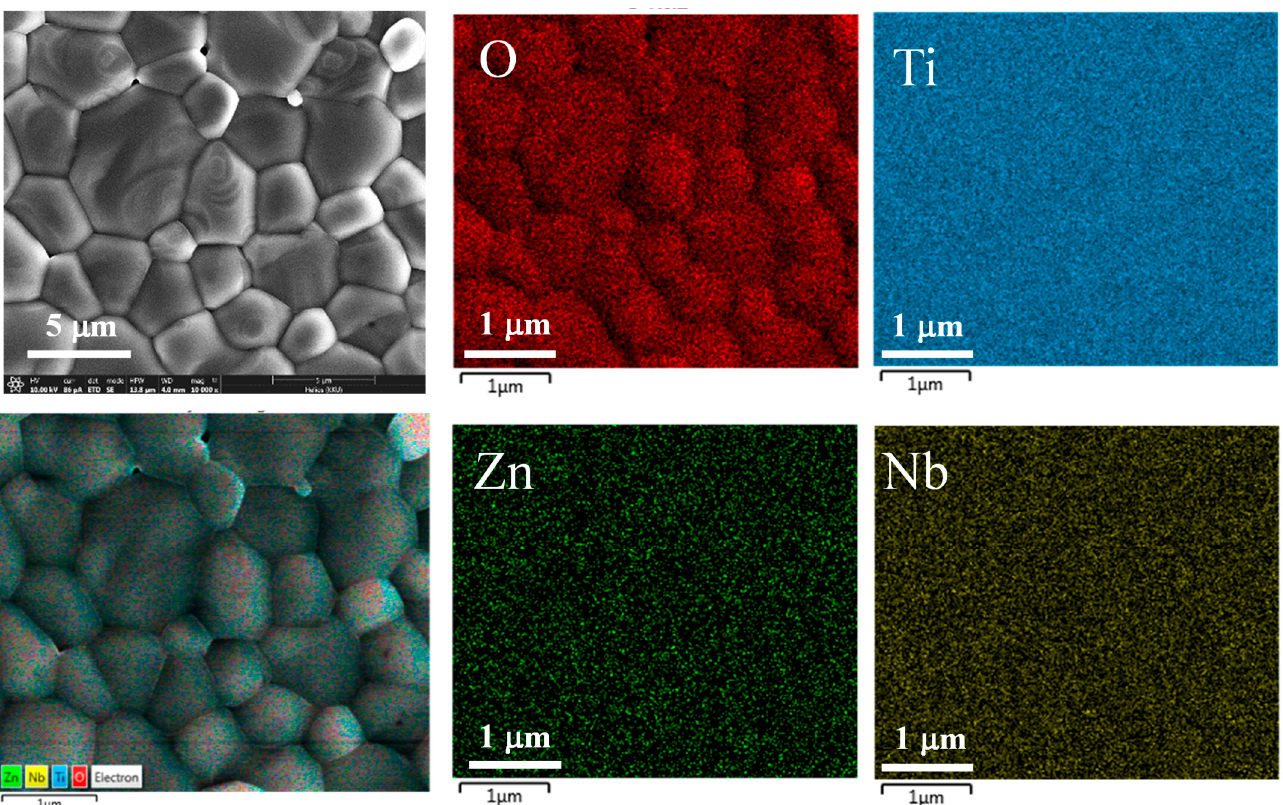
Figure 4. The elements mapping of 2.5% ZNTO ceramic; the Zn, Nb, Ti and O dopants are homoge- neously dispersed in the grains and grain boundaries.